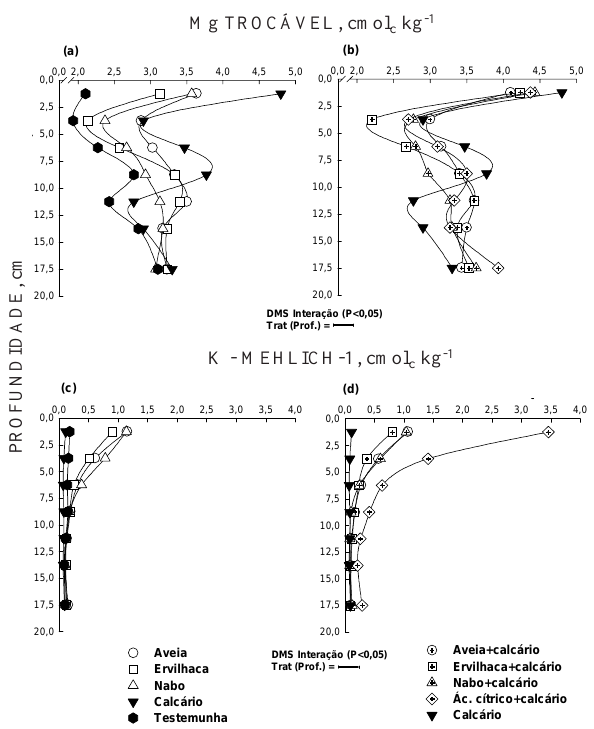
Figura 3. Valores dos atributos químicos no perfil do solo após 60 dias da aplicação superficial dos resíduos, isolados e junto com calcário, em colunas indeformadas, coletadas em área de plantio direto: magnésio trocável (a) e (b) e potássio disponível (Mehlich-1) (c) e (d).